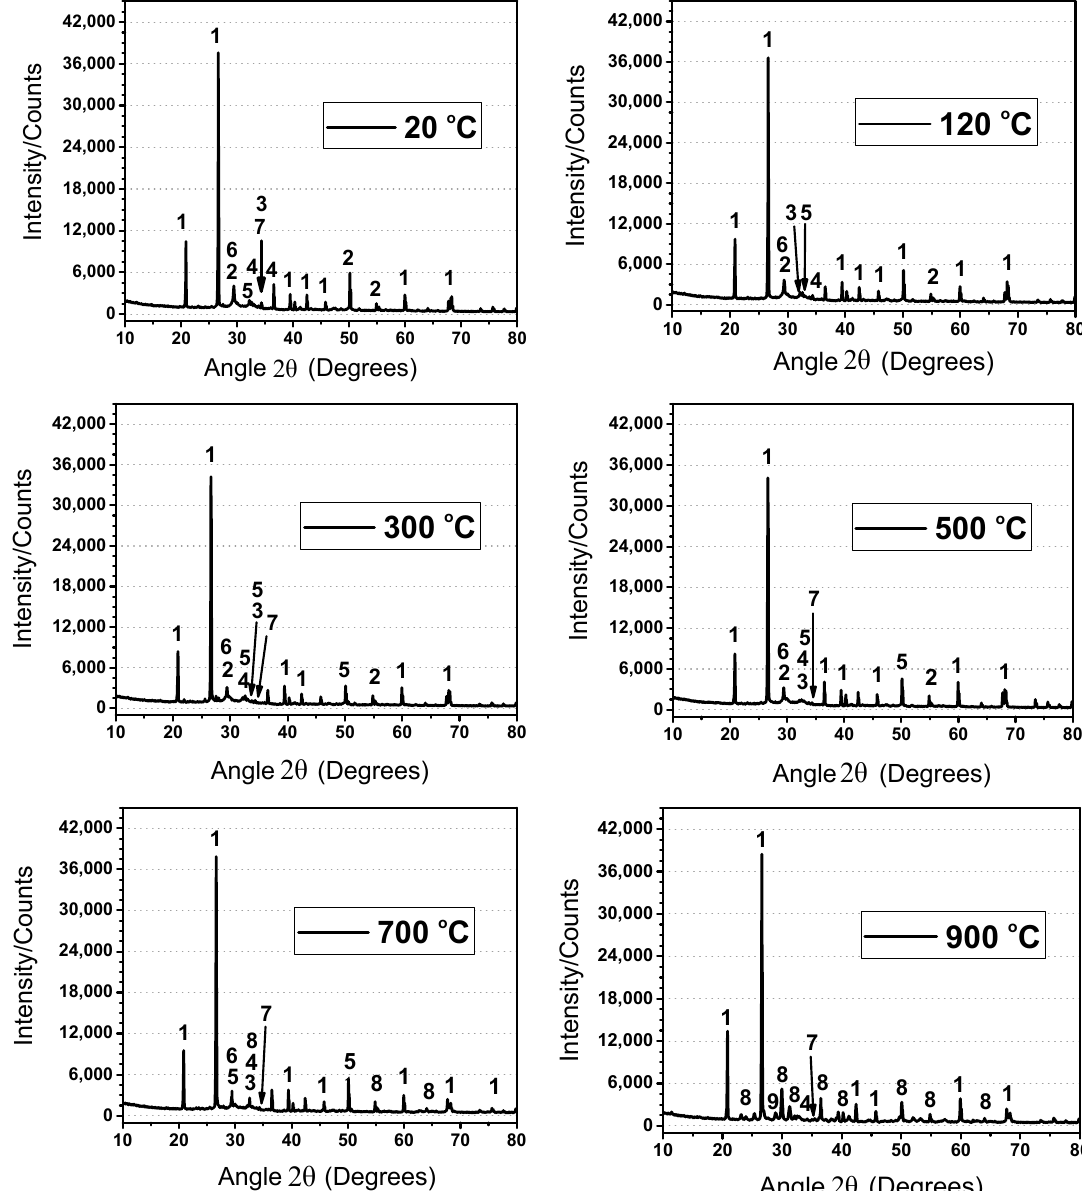
Figure 17. X- ray diffraction (XRD) patterns of RPC at different temperatures. Where: 1 >> Silica (SiO 2 ); 2 >> C-S-H gel; 3 >> C 3 A; 4 >> C 2 S; 5 >> C 3 S; 6 >> CaCO 3 ; 7 >> CH; 8 >> β -CaSiO 3 (Wollastonite), 9 >> CaO.